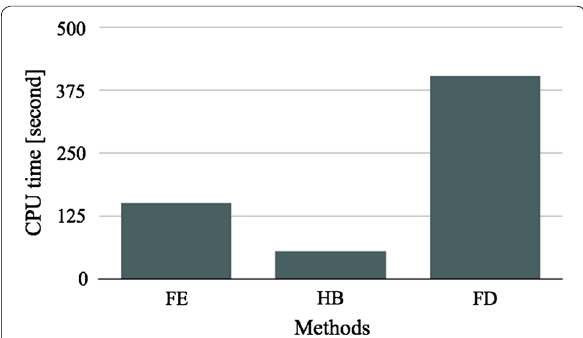
Fig. 10 The total CPU times required by the FE, HB and FD methods for the topographic model